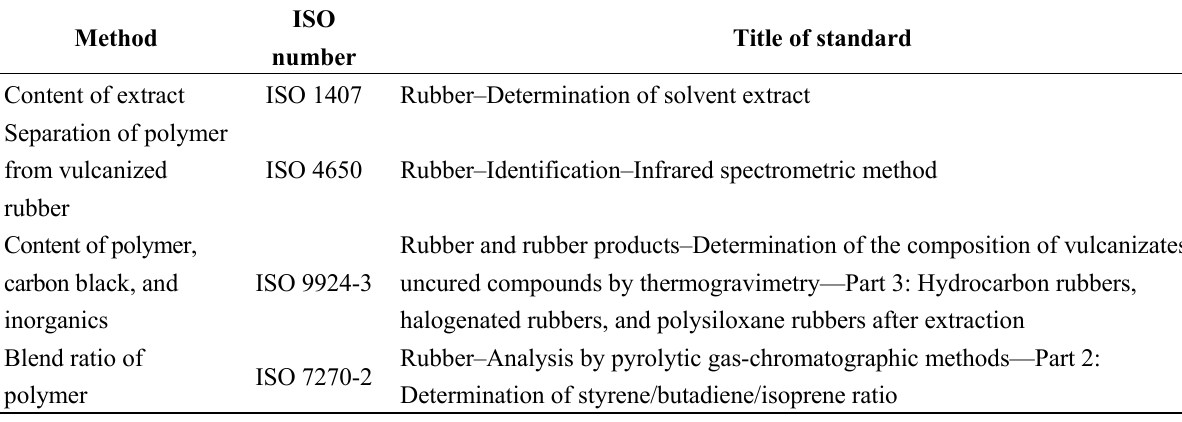
Table 4. ISO standards related to composition analysis by separation of vulcanized rubber products published in ISO technical committee (TC) 45 “Rubber and rubber